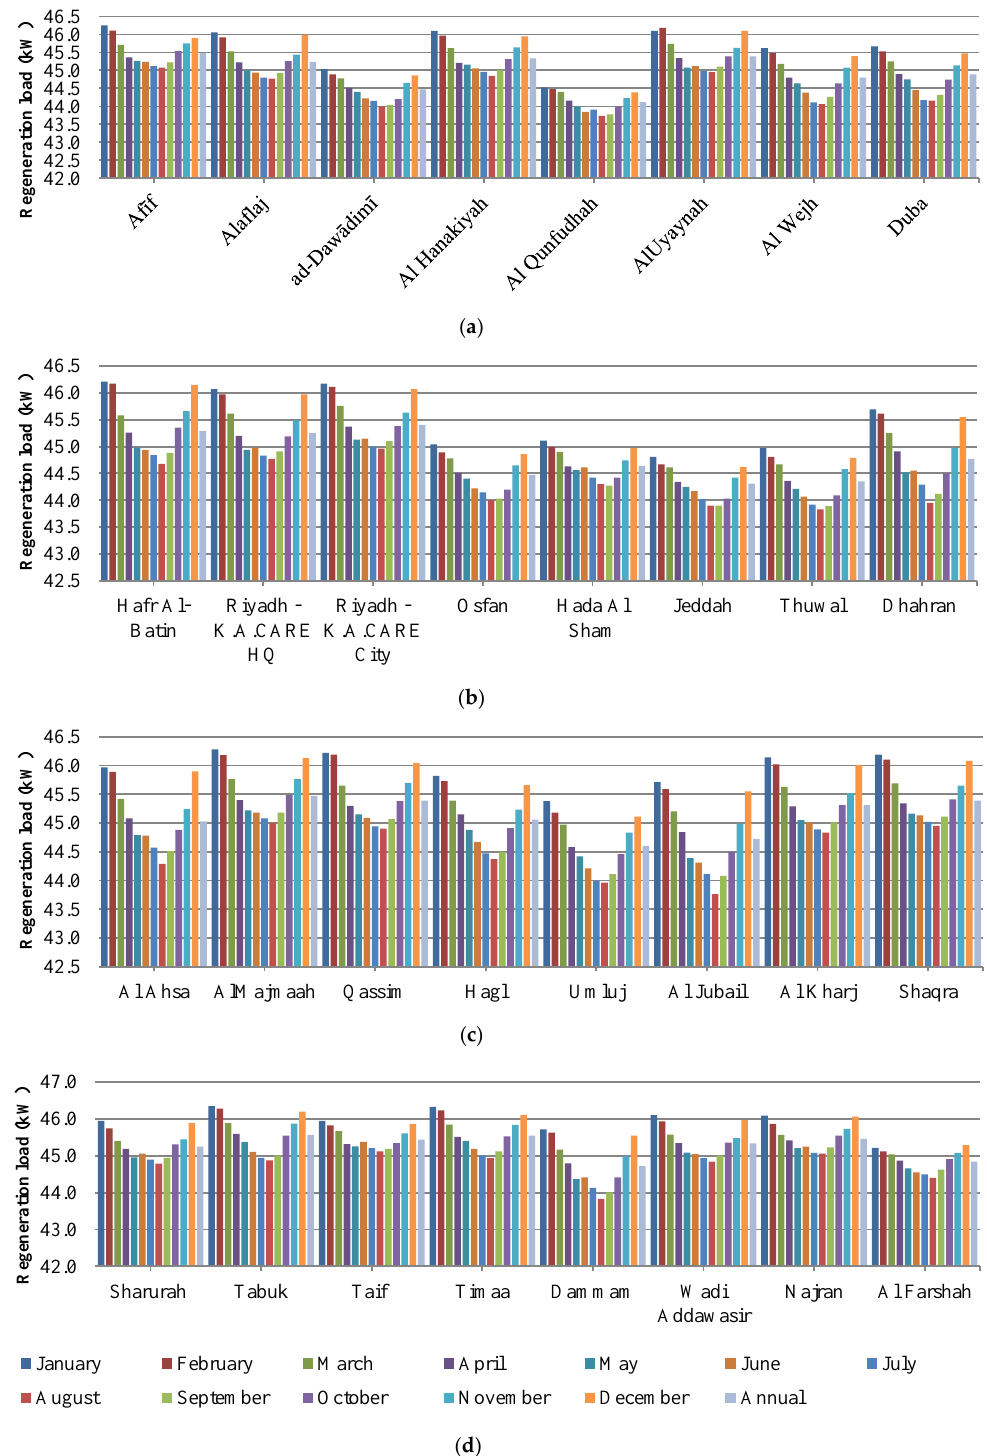
Figure 12. Monthly variations of regeneration load for ( a ) Afīf, Alaflaj, ad-Dawādimī, Al Hanakiyah, Al Qunfudhah, AlUyaynah, and Al Wejh, Duba; ( b ) Hafr Al-Batin, Riyadh—K.A. CARE HQ, Riyadh—K.A. CARE City, Osfan, Hada Al Sham, Jeddah, Thuwal, and Dhahran; ( c ) Al Ahsa, AlMajmaah, Qassim, Hagl, Umluj, Al Jubail, Al Kharj, Shaqra; ( d ) Sharurah, Tabuk, Taif, Timaa, Dammam, Wadi Addawasir, Najran, and Al